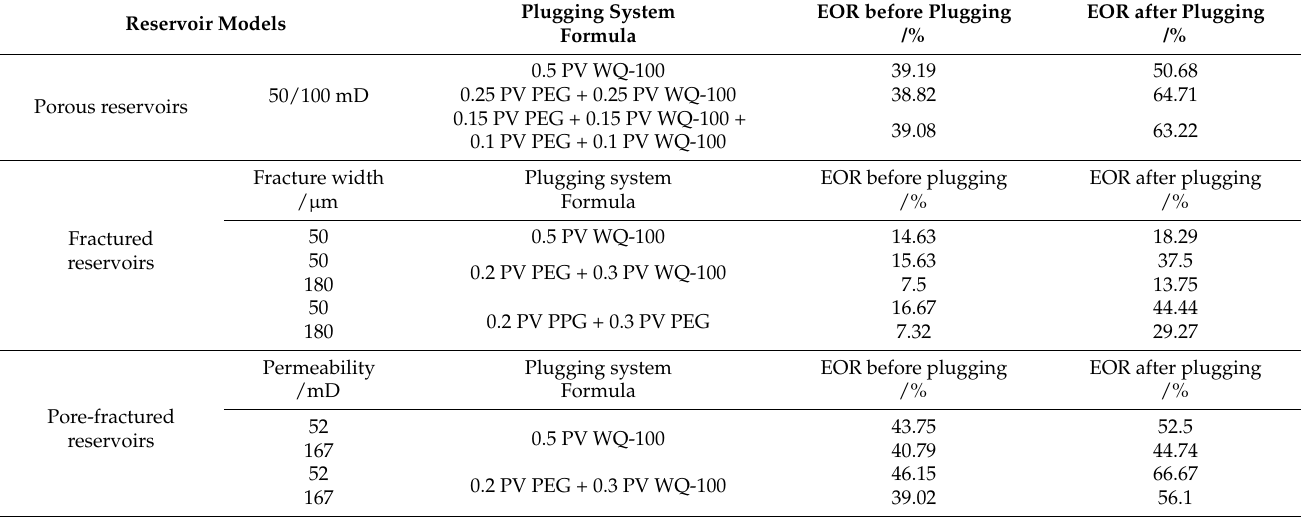
Table 8. Plugging efficiency of multiple pre-crosslinking gel particle on the fractured reservoir. Reservoir